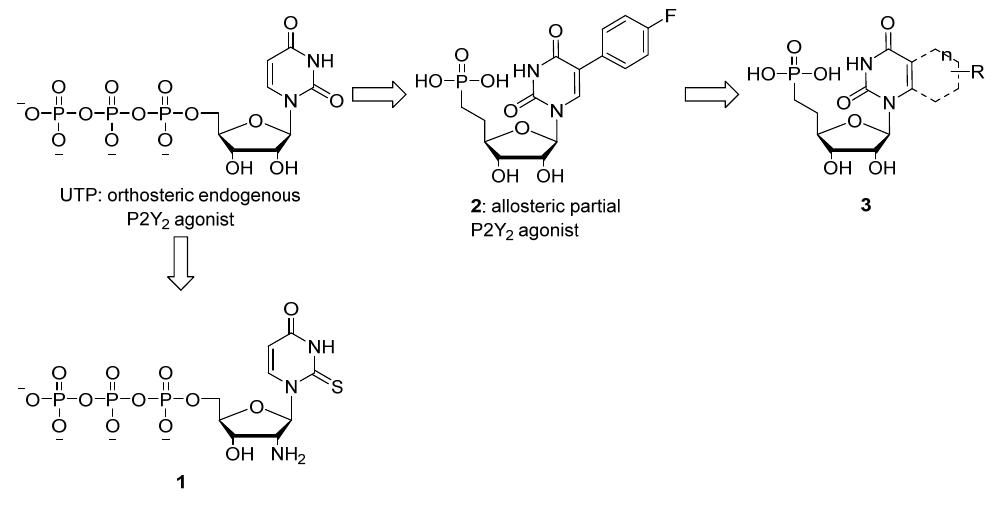
Figure 1. Structure of UTP, the selective P2Y and the target nucleoside phosphonates 3